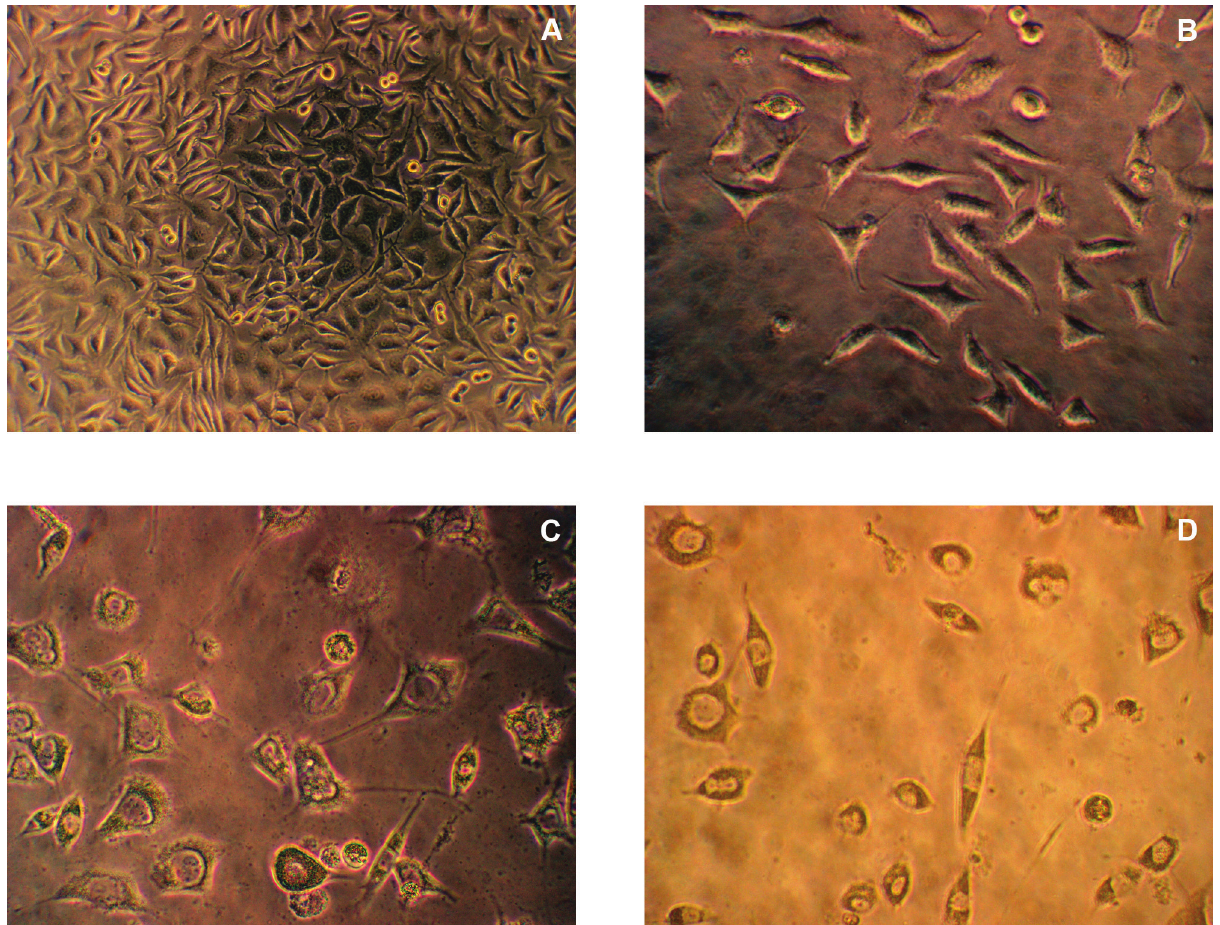
Figure 5. Morphological changes for L929 viewed by inverted microscope after venom-antivenom treatment. ( A ) Untreated cells, ( B ) cells treated cells with 1 IC of native venom-antivenom mixture, and ( D ) cells treated with 5 IC treated with 3 IC 50 antivenom mixture (magnification: